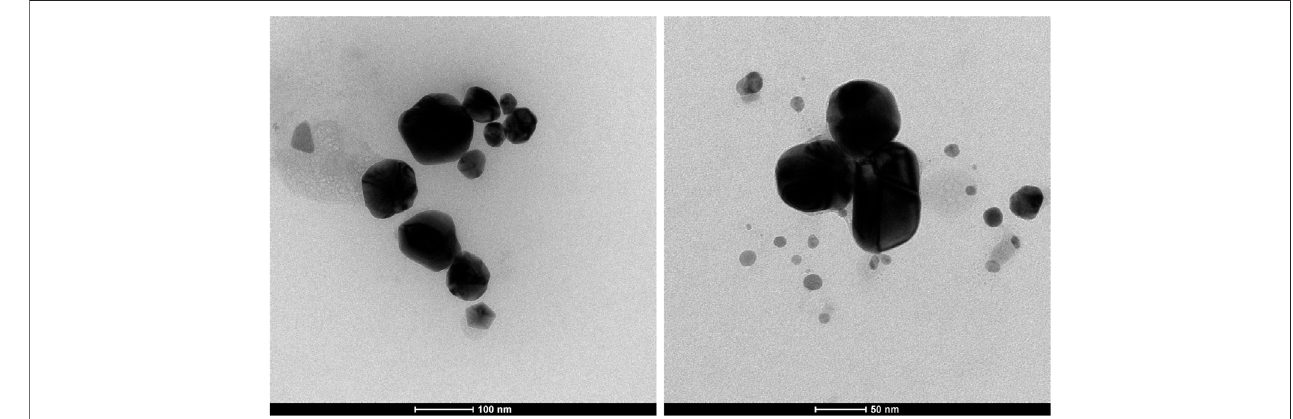
FIGURE 1 | TEM images of AgN.